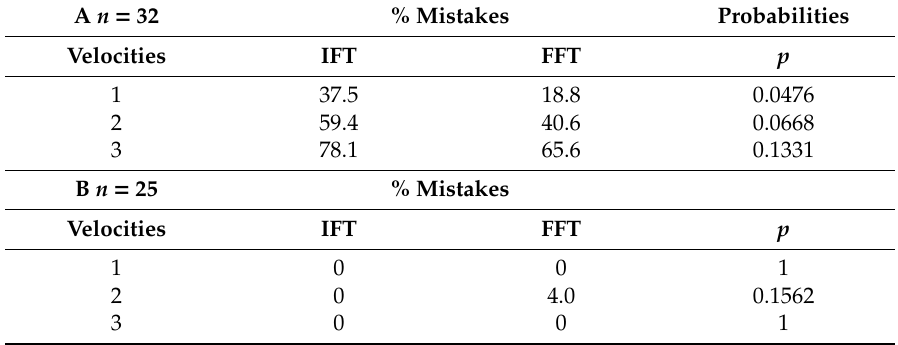
Table 3. Comparison of Student’s t-test of error percentages between IFT and FFT tests for groups A and B and for each velocity separately.